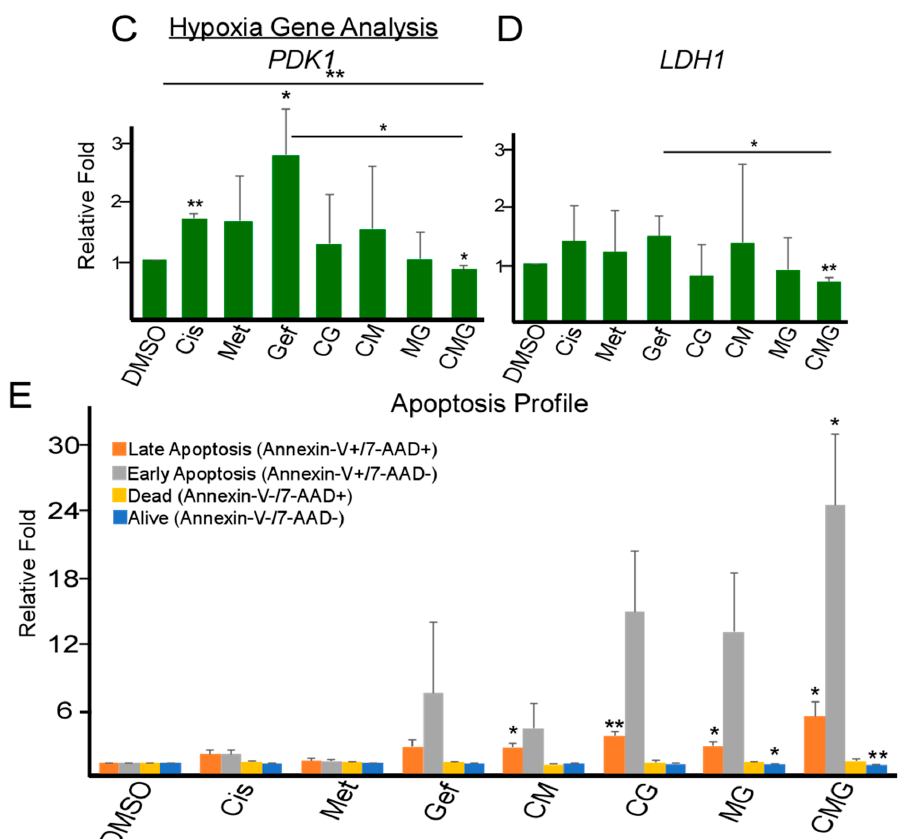
Figure 3. Co-inhibition of hypoxia and EGFR suppresses cisplatin-upregulated hypoxia and promotes apoptosis in TNBC. ( A , B ) Relative luciferase reporter expression of MDA-MB-231 TNBC cells after 24 h of drug treatment. Cells were transfected with HRE-Luciferase or ODD-Luciferase and normalized with the pRL-SV40P Renilla construct. The following day, cells were treated with DMSO (vehicle control), cisplatin (Cis, 5 µM), gefitinib (Gef, 5 µM) and/or metformin (Met, 25 µM). Data represent means ± SD, n = 3 repeats; * p < 0.05, ** p < 0.01. ( C , D ) RT-qPCR analysis and comparison of relative mRNA expression levels of hypoxia genes (PDK1 and LDH1) after treatment for 48 h as described in (A,B). Data represent means ± SD, n = 3 repeats; * p < 0.05, ** p < 0.01. ( E ) Flow cytometric analysis of cell states (Dead, Alive, Early Apoptosis or Late Apoptosis) based on Annexin-V/7-AAD markers after 72 h of exposure to DMSO (vehicle control), cisplatin (Cis, 5 µM), gefitinib (Gef, 5 µM) and/or metformin (Met, 25 µM). Data represent means ± SE, n = 3 repeats; * p < 0.05, ** p < 0.01.